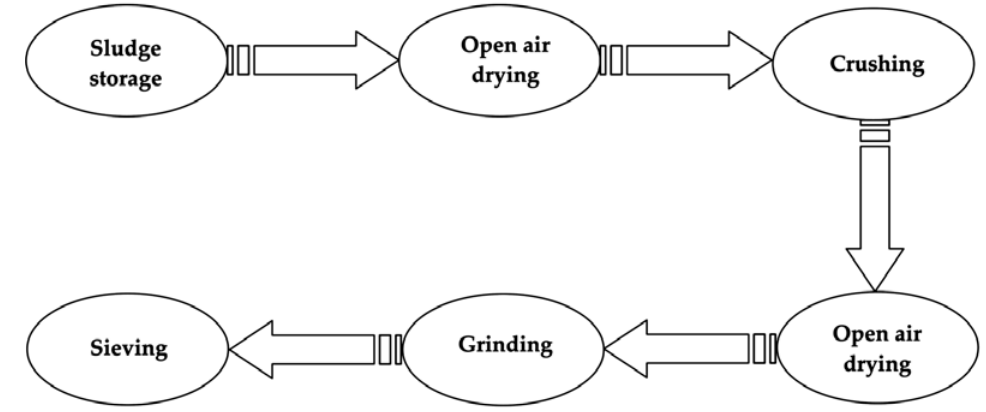
Figure 11. Design of marble filler production